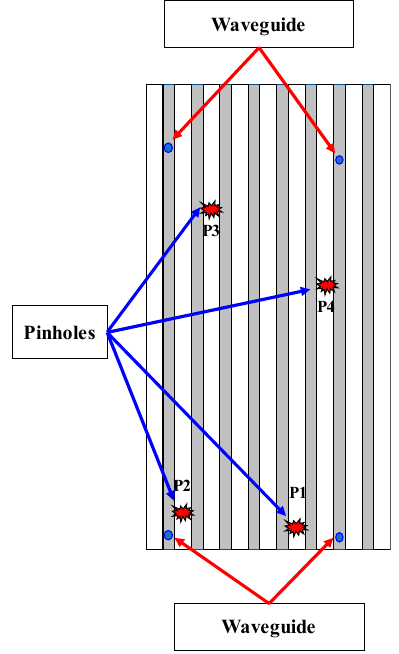
Figure 5. Locations of the pinholes and waveguides .